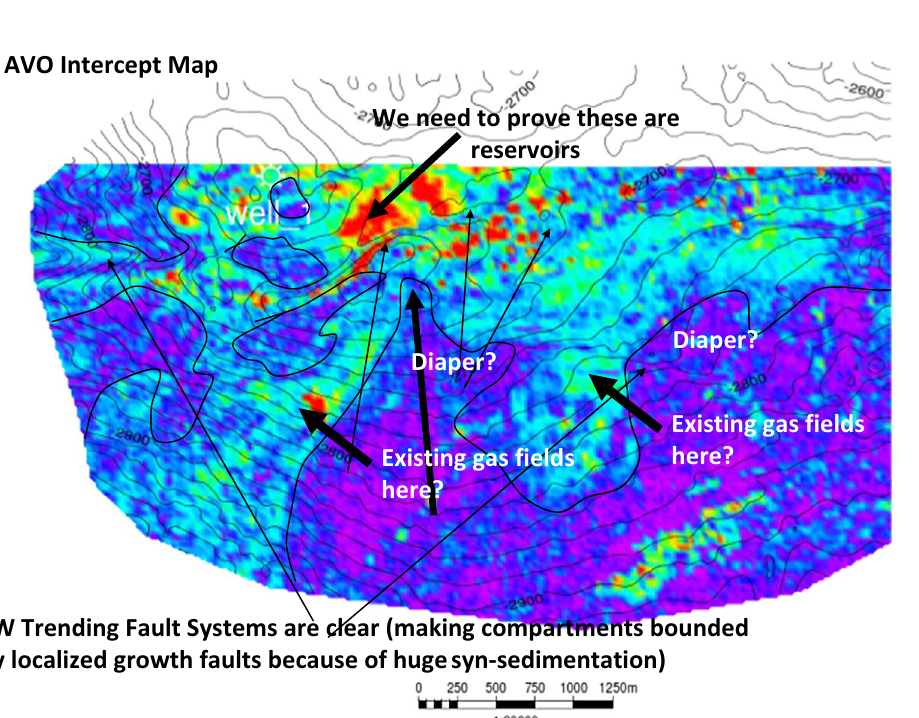
Fig. 8 AVO intercept superimposed on a two-way time contour